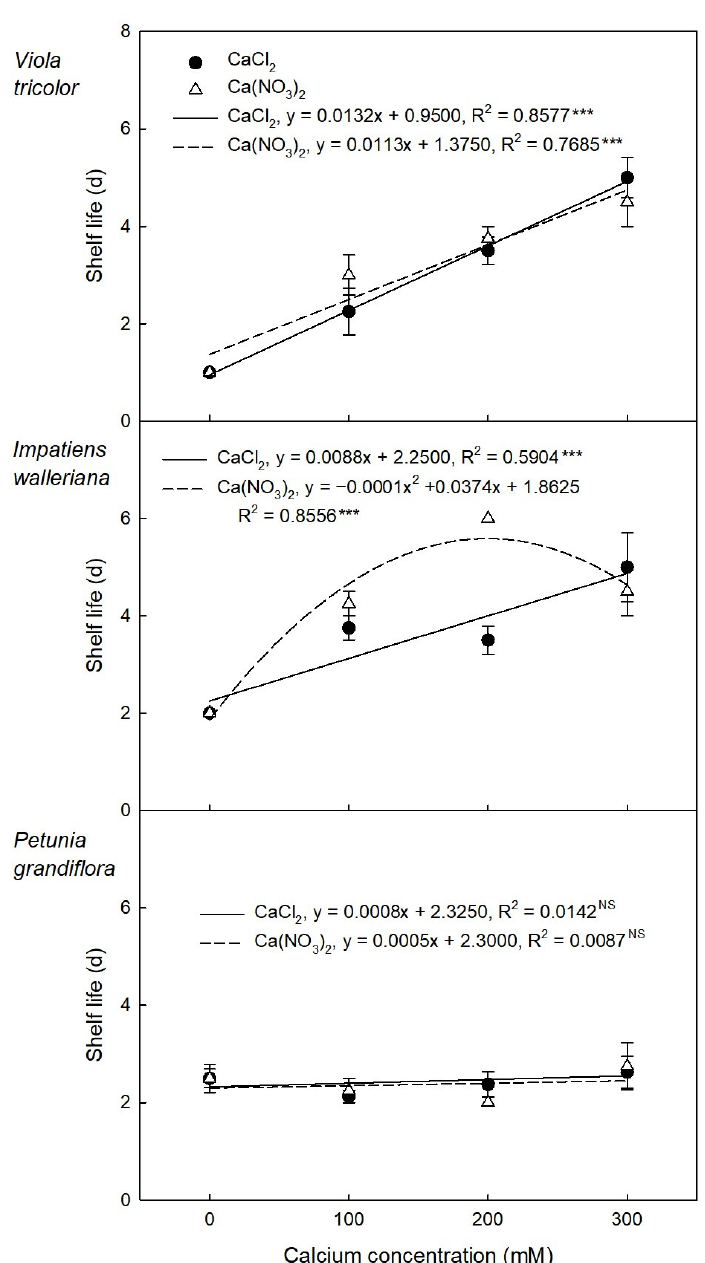
Figure 6. Influence of concentrations of CaCl 2 and Ca(NO 3 ) 2 on shelf life of V. cornuta (viola), I. walleriana (impatiens), and P. grandiflora (petunia) in pre-drench application. Each data point represents the mean of shelf life, but the analysis was performed with all data (n = 4). Bars represent standard error. NS, nonsignificant; ***, significant at P ≤ 0.001.